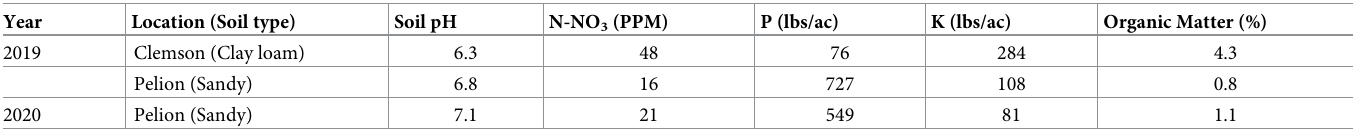
Table 3. Soil chemical properties at the locations where dry pea was grown in 2019 and 2020. Location (Soil